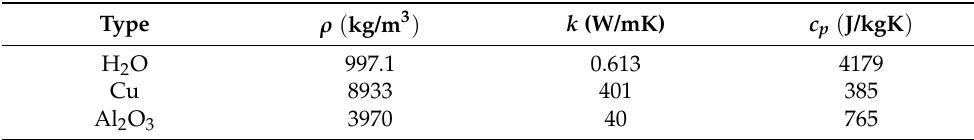
Table 1. Nanoparticles and H 2 O thermophysical properties [40].